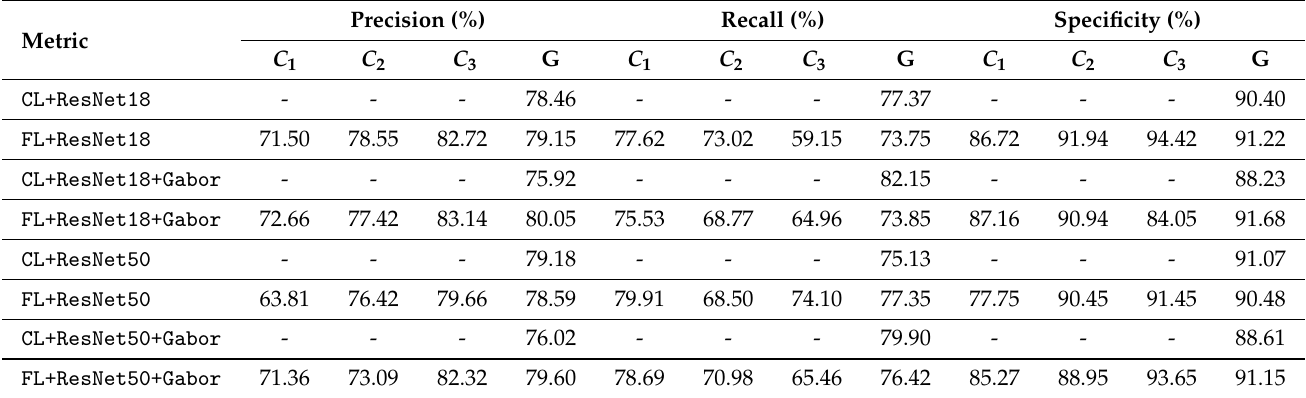
Table 2. Patch-wise result comparison on the test datasets with the CL and the FL global models.